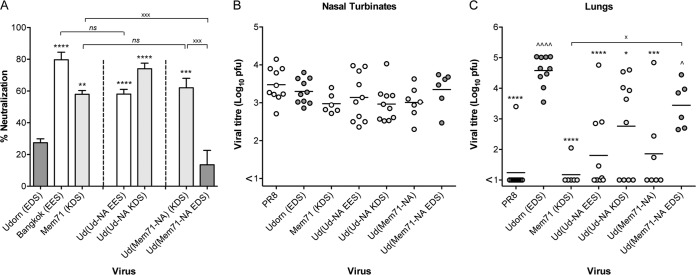
In vitro neutralization and in vivo progression of mutant Udorn viruses. (A) Udorn viruses (5,000 PFU) bearing changes in amino acid residues 368 to 370 of the viral NA were mixed with untreated saliva or RPMI plus BSA as a control at a 9:1 (vol/vol) ratio of virus to saliva. The mixtures were then incubated at 37°C for 30 min before being added to MDCK cell monolayers, and viral infectivity was determined by plaque assay. The percentages of virus neutralized by saliva are shown. The amino acid sequence from 368 to 370 is denoted by differently shaded bars: EDS, dark gray; KDS, light gray; EES, white. The data represent means and standard deviations of the results of at least 2 individual experiments, each performed in triplicate. (B and C) BALB/c mice were infected via the URT route with 104.5 PFU of each virus. After 6 days, nasal turbinates (B) and lungs (C) were removed, and viral titers in homogenates were determined by plaque assay on MDCK cell monolayers. Individual titers (circles) and the mean viral titers of 6 to 10 mice per group (horizontal lines) are shown, expressed as titers per organ. The residues in parentheses denote the unmodified or genetically altered sequence. Dark-gray circles, viruses containing NA bearing EDS; light-gray circles, viruses bearing KDS; open circles, viruses bearing EES. The PR8 NA sequence is HSS at the corresponding location. Compared to Udorn, *, P < 0.05; **, P < 0.01; ***, P < 0.001; and ****, P < 0.0001. Compared to PR8, ^, P < 0.05; and ^^^^, P < 0.0001. For other important comparisons indicated by a bracket, x, P < 0.05; xxx, P < 0.001; and ns, not significantly different.